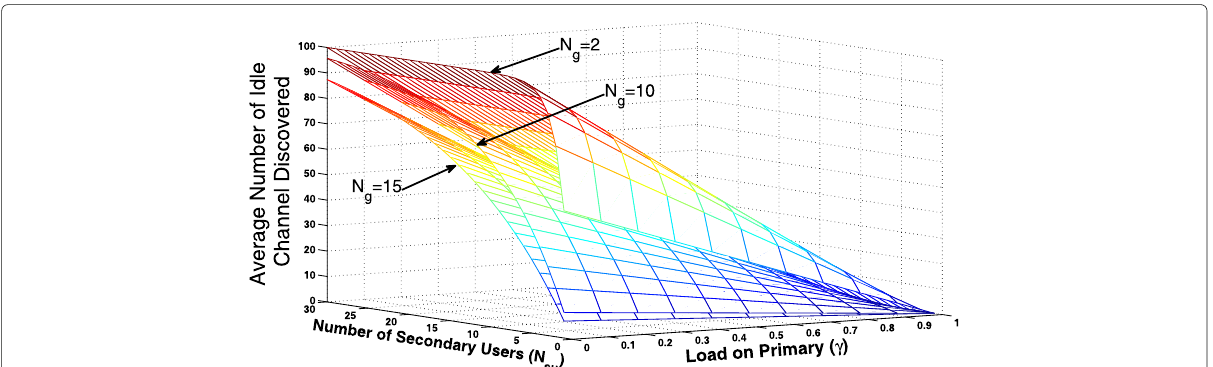
Fig. 7 Average number of idle channels discovered by SUs with variations in the number of secondary users and traffic load on the primary